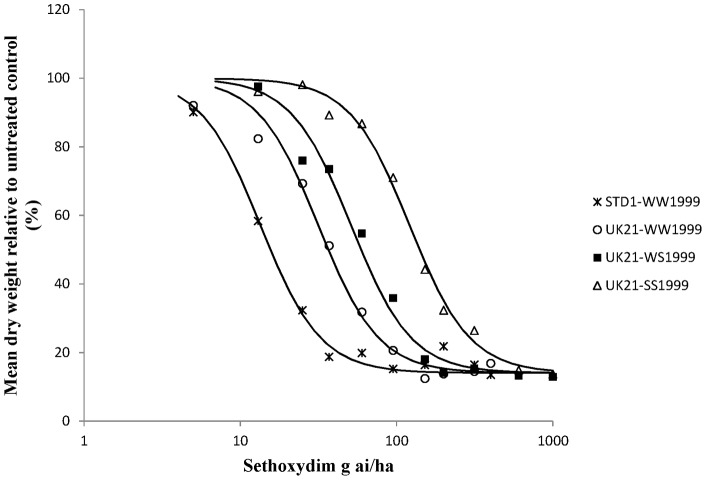
Sethoxydim dose response tests on four plant groups: homozygous wild type WW1999, heterozygous WS1999 and homozygous mutant SS1999 from the mixed resistant population UK21 and standard sensitive STD1 plants (WW1999) for comparison.Observed values represent dry weight relative to untreated (%) averaged across mother plants. The curves are constructed based on the average GR50 across biological and technical replicates.